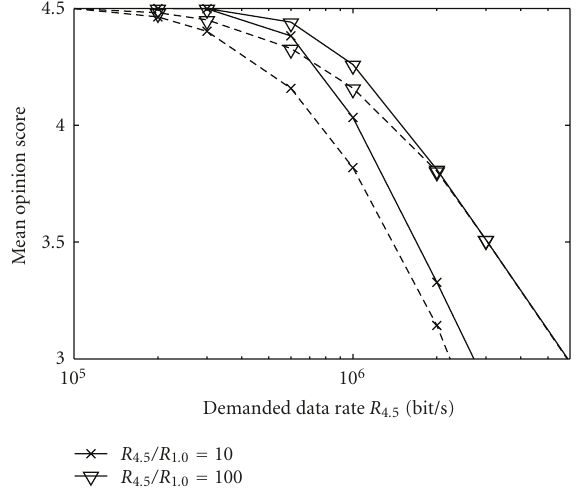
Figure 15: Gain in average MOS for di ff erent ratios of low-rate and high-rate users.